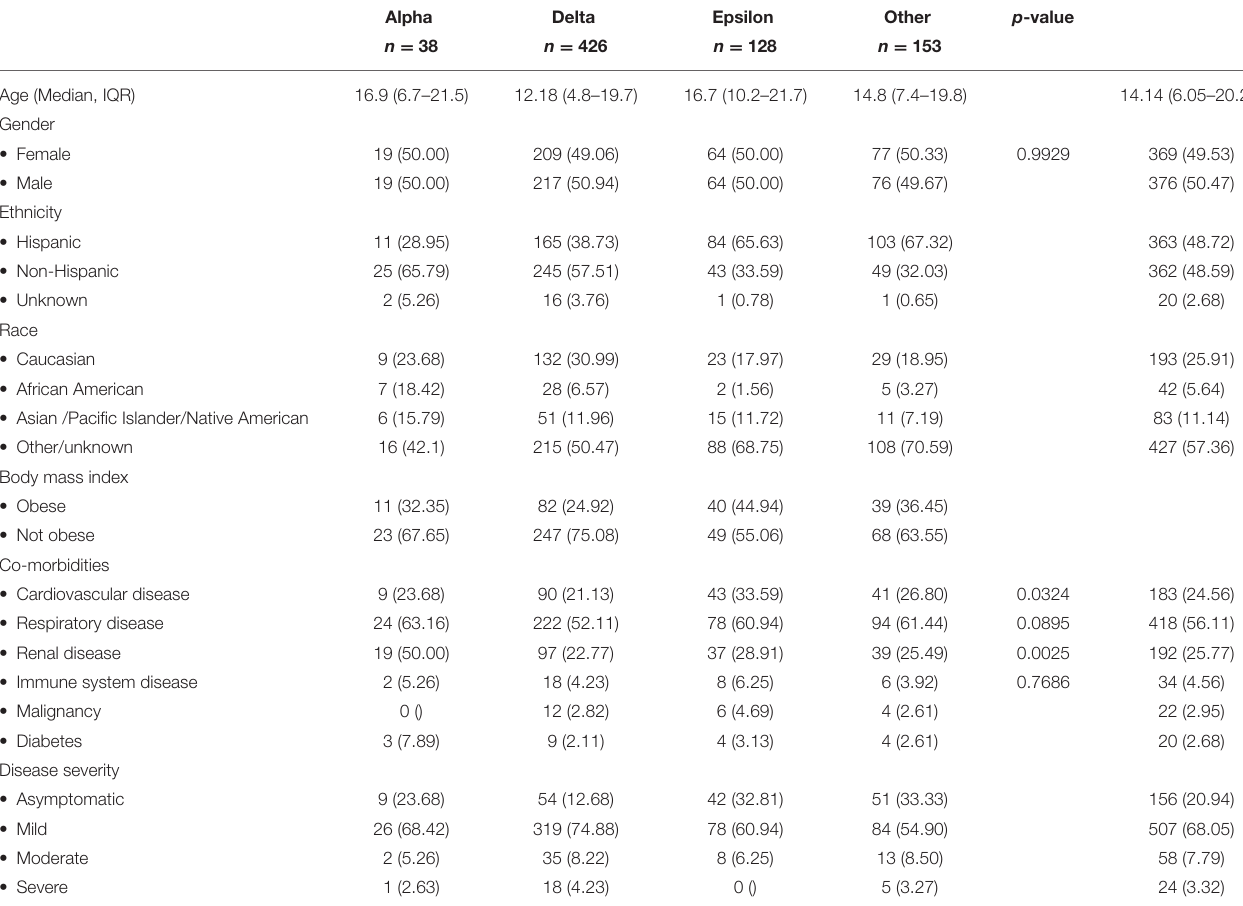
TABLE 2 | Characteristics of the Patients at diagnosis by exposure to different SARS-CoV-2 variants. Alpha Delta Epsilon Other p -value n =